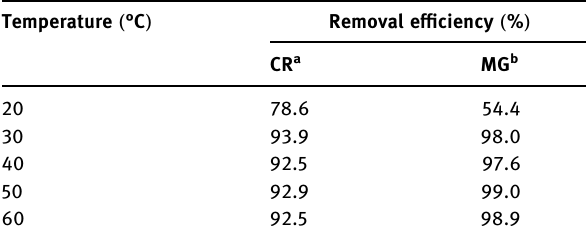
Table 2: E ff ects of temperature on the removal e ffi ciency of CR and MG Temperature ( °C )